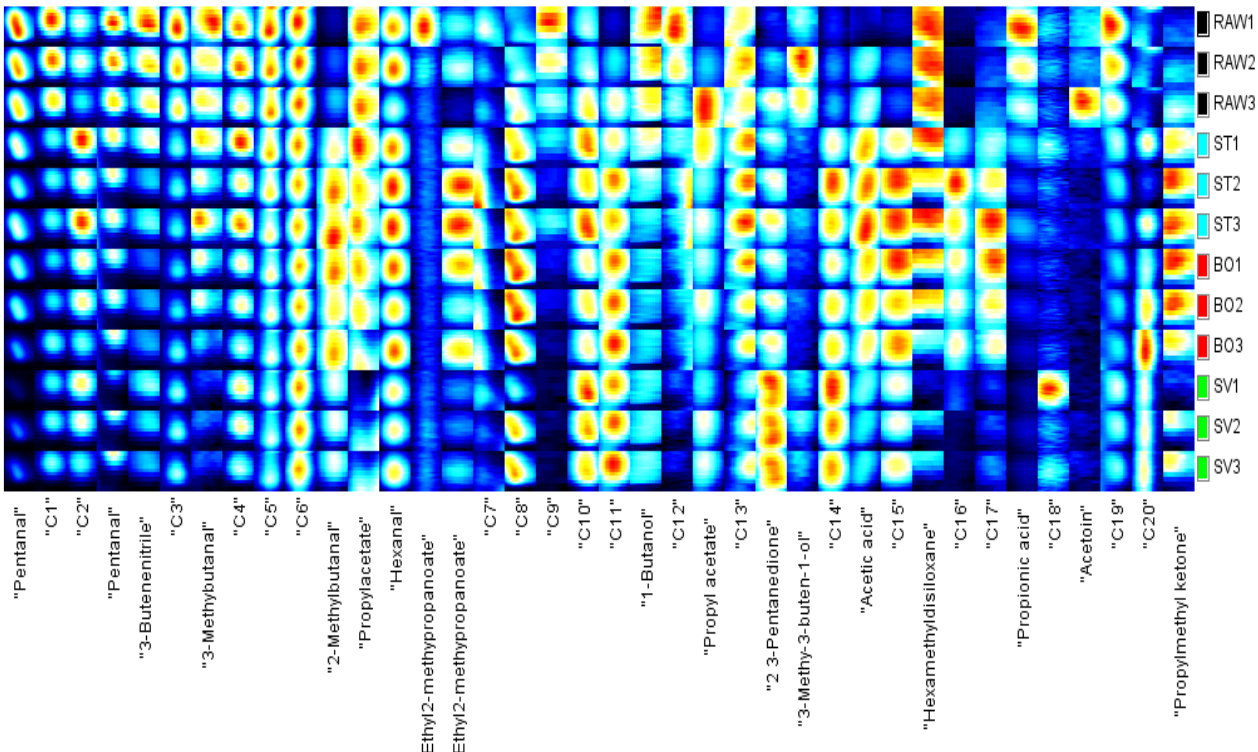
Figure 8. Fingerprint of the squid ( Symplectoteuthis oualaniensis ) mantle muscle with different cooking treatment. RAW: raw squid; ST: steaming; BO: boiling; SV: sous vide. The y axis on the right side of the GC-IMS fingerprint is the SMM sample number, and the x axis is the name of the volatile compounds; the numbers C1–C20 indicate the compounds that had not been